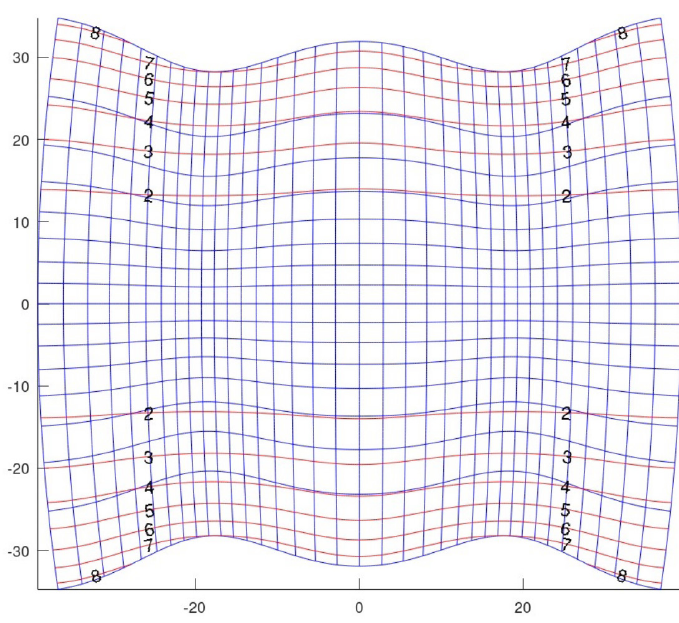
Fig. 16. The cartographic grid and the distribution of distortions in the projection created with the use